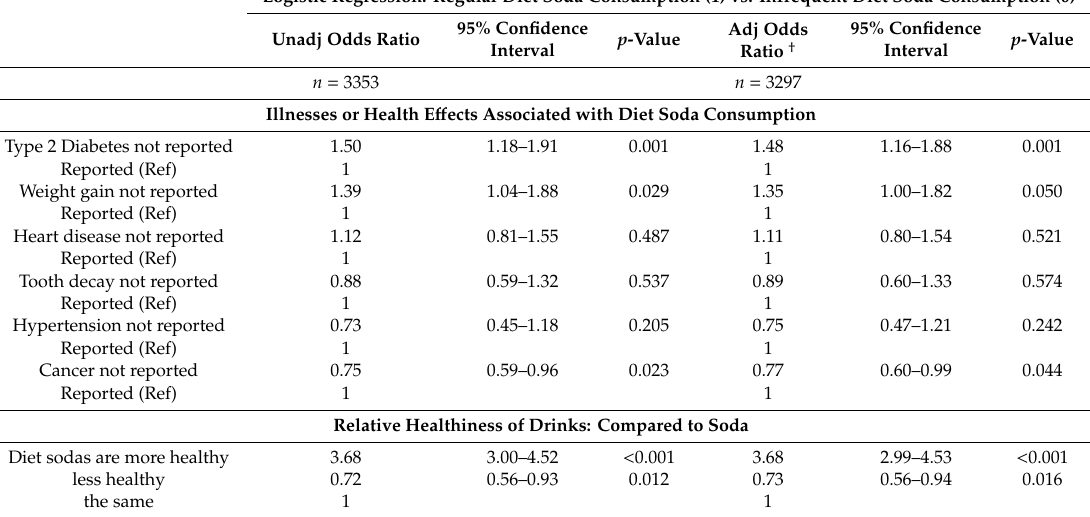
Table 3. Logistic regression predicting diet soda consumption based on diet soda-related knowledge and